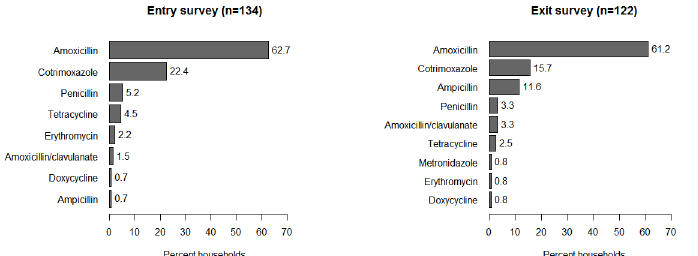
Fig 1. Proportion of household respondents that mentioned an antibiotic * during the entry and exit